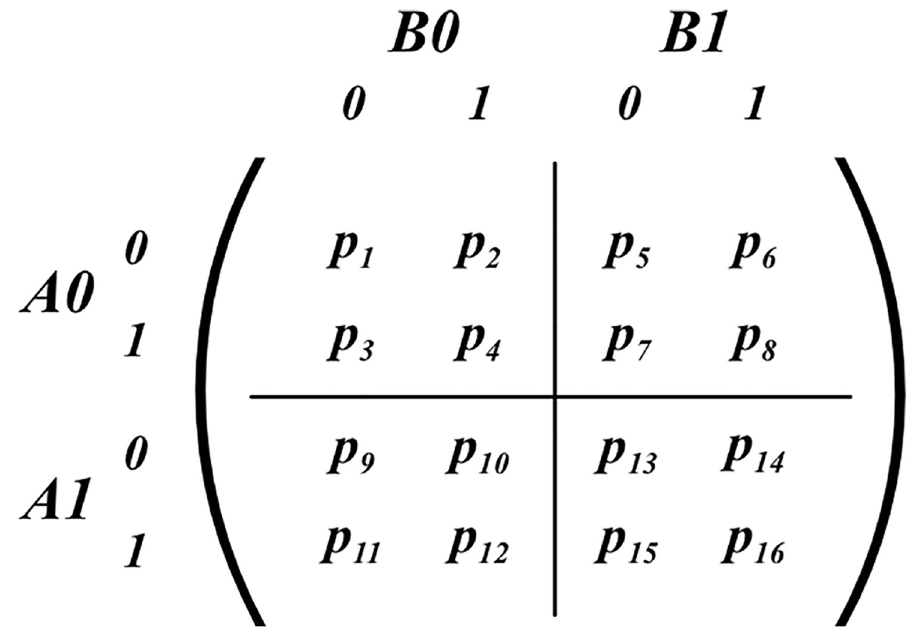
Fig 1. Four pairwise distributions in an EPR